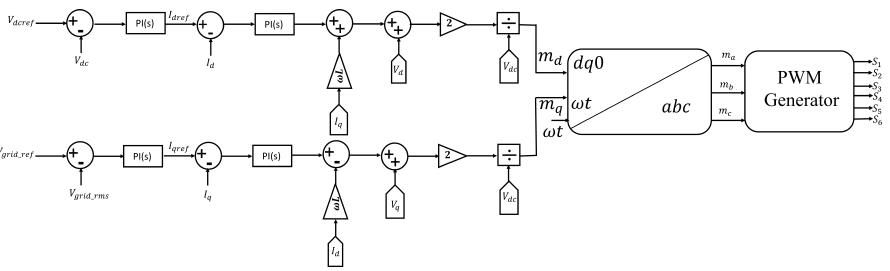
Figure 3. Block diagram of the DC link voltage and line current control [21], © 2021 IEEE.